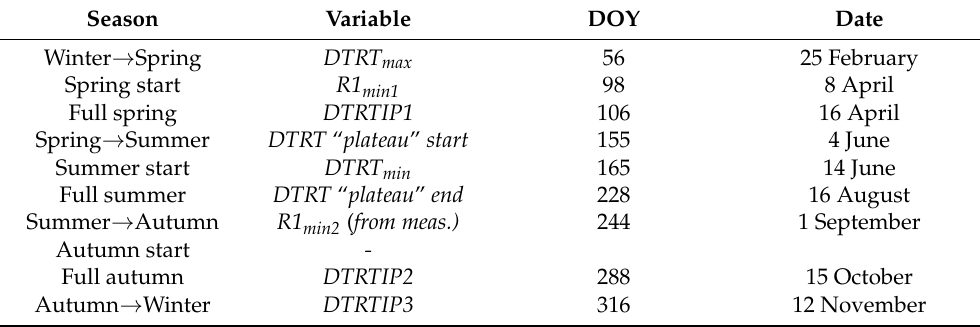
Table 7. Seasonal transition based on R 1 and DTRT extreme values and IP for R.S. climate